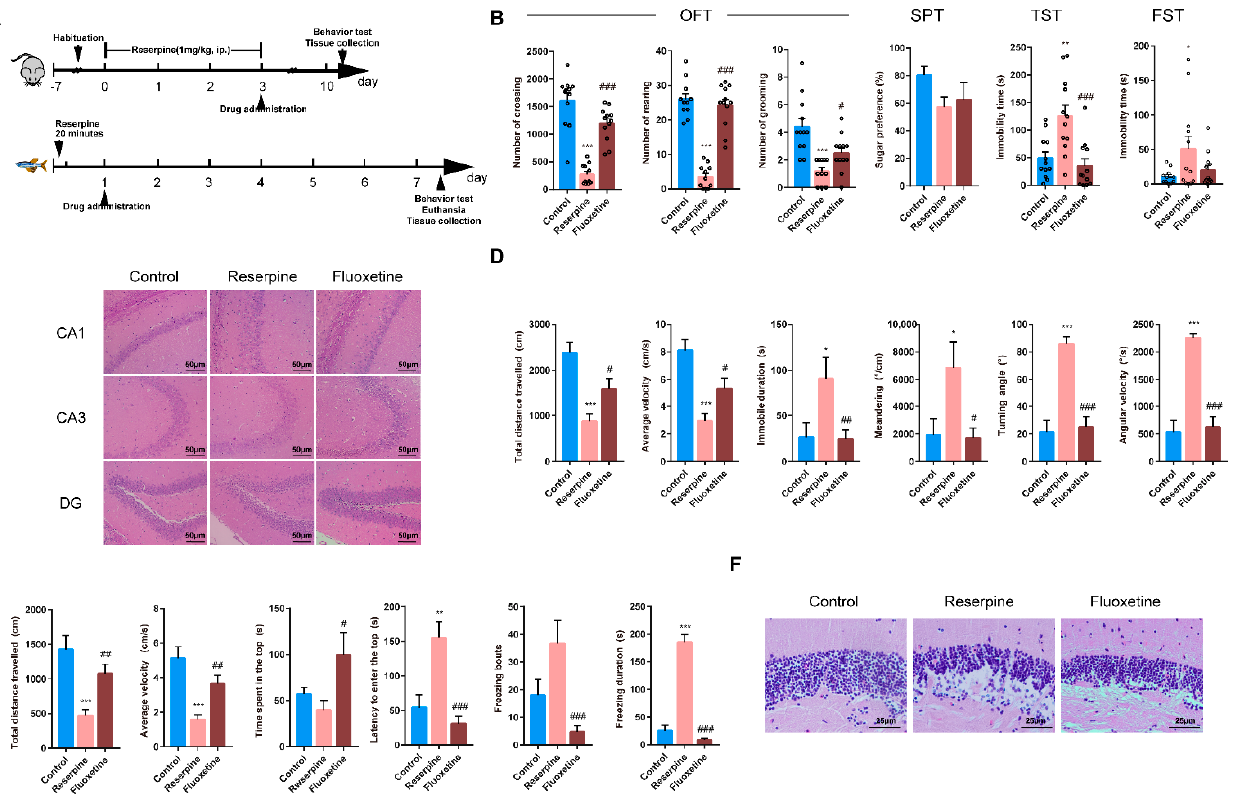
Figure 2. Experimental design and effect of reserpine on mice and zebrafish. ( A ) Experimental design for reserpine. ( B ) The results of behavioral tests for OPT, SPT, FST and TST of reserpine in mice. The round symbols indicate data distribution. ( C ) Histopathological observation of mice hippocampus, 200×. ( D , E ) The results of behavioral tests for OFT and NTT of reserpine in zebrafish. ( F ) Histopathological observations on adult zebrafish brain, 200×. Data are represented as mean ± SEM. * p < 0.05, ** p < 0.01, *** p < 0.001, compared with control; # p < 0.05, ## p < 0.01, ### p < 0.001, compared with CUMS reserpine group.